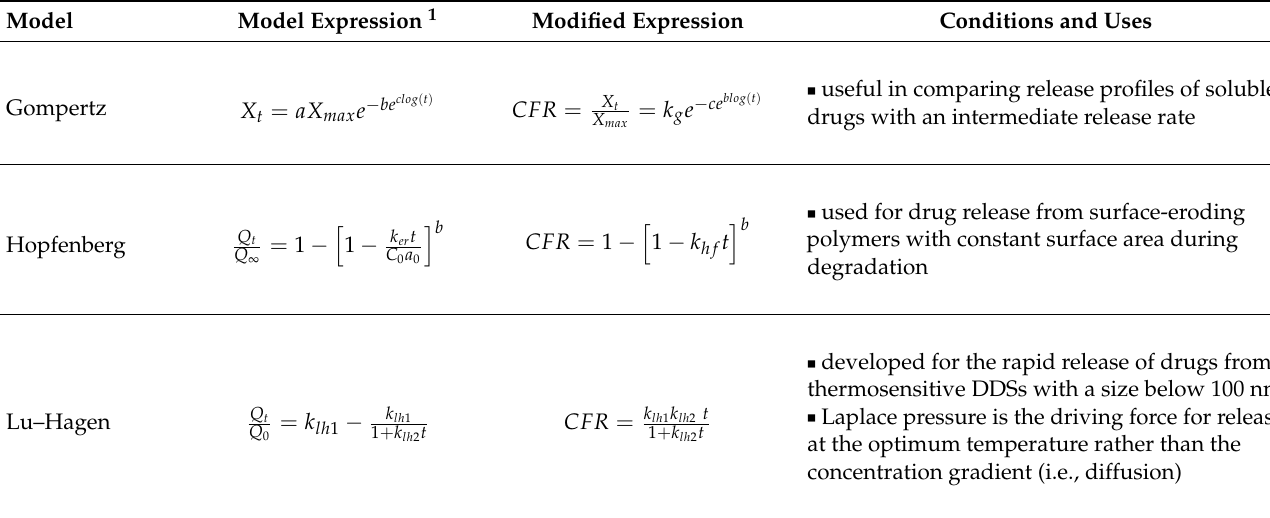
Table 1. The advantages and disadvantages of drug delivery trigger mechanisms.